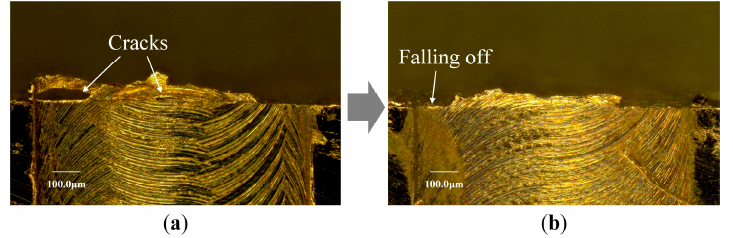
Figure 10. The tearing and falling of exit burr. ( a ) Micro cracks in exit burr. ( b ) Falling of exit